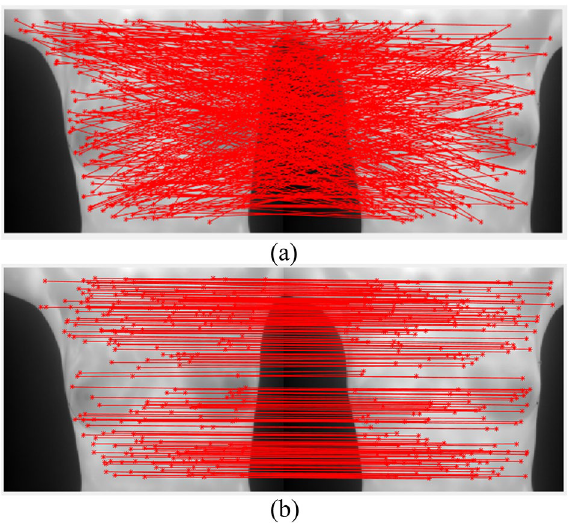
Figure 17. Matched points: ( a ) in the initial matching and ( b ) after deletion of the mismatched points.